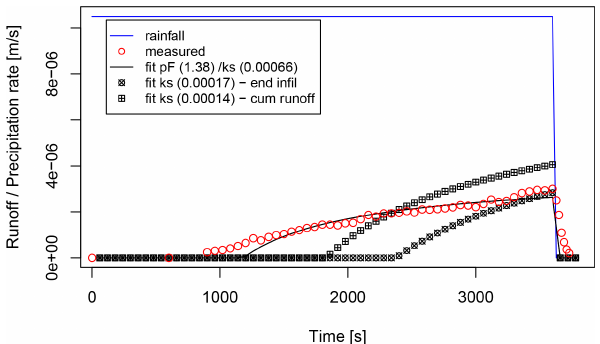
Figure 7. Comparison of parameter fitting strategies: k s fit refers to variation of hydraulic conductivity (kgm − 3 s − 1 ) only (state of the art in EROSION-3D) with a fixed p F value of 2.13, estimated from initial soil moisture. Fit of p F /k s refers to the best simulation found by Monte Carlo